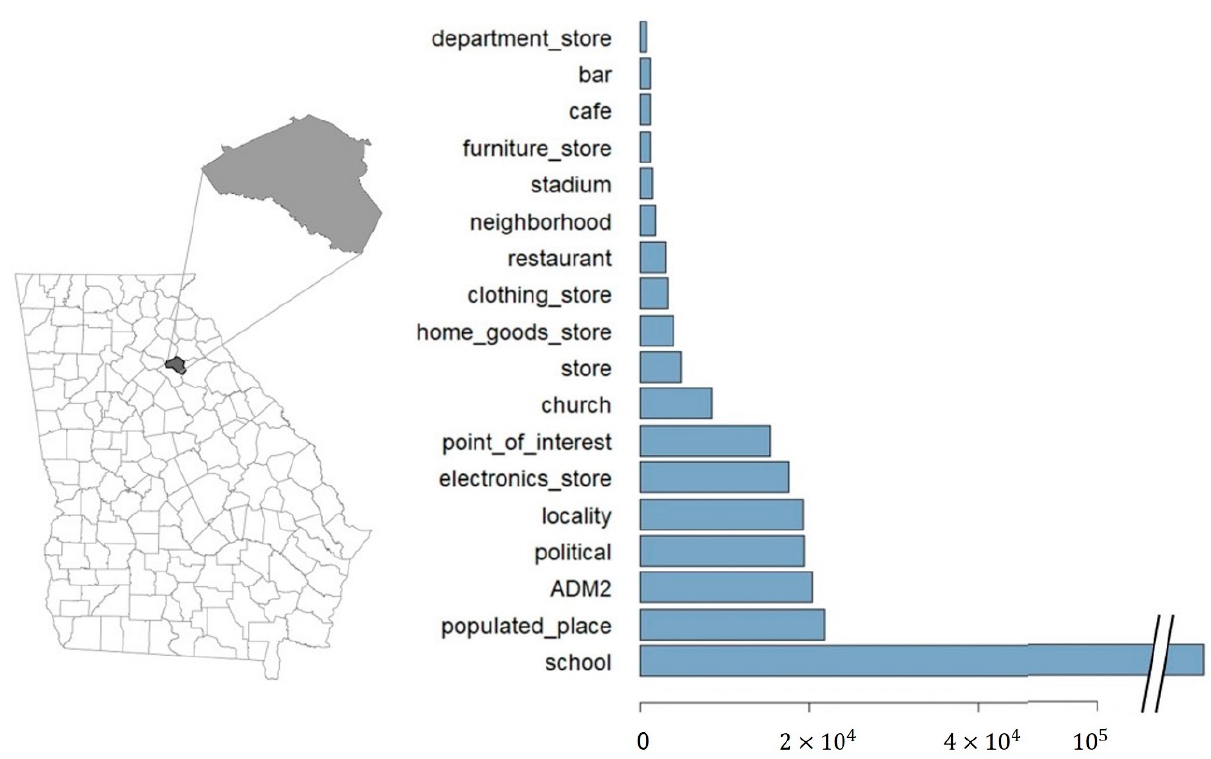
Figure 3. The number of tweets collected for each place type in the target study area (Athens, GA, USA, on the left-hand side).